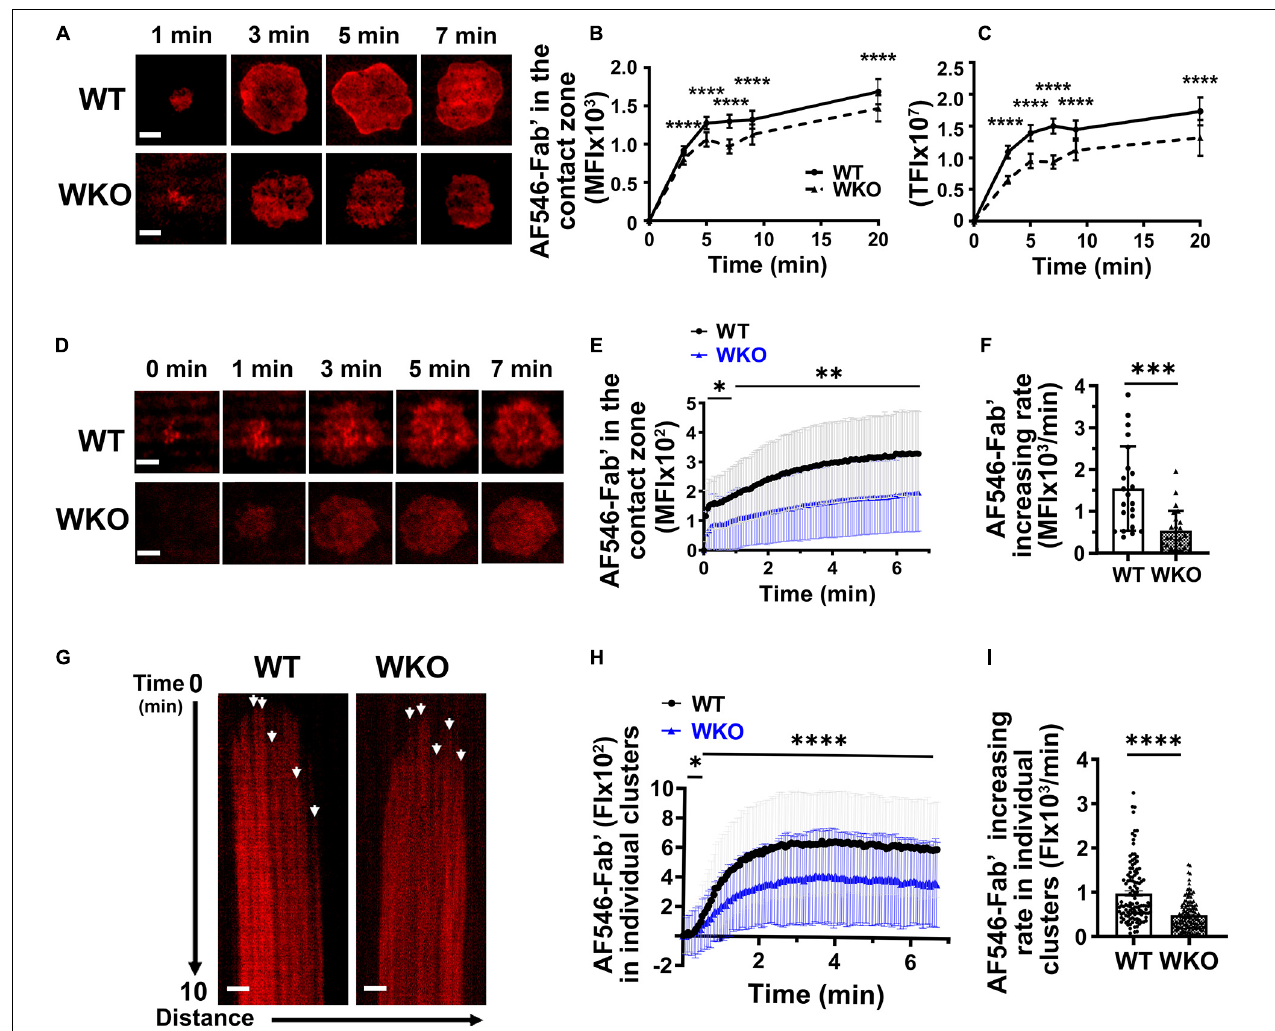
FIGURE 3 | WASp promotes BCR clustering in response to Fab’-PLB. GCBs isolated from SRBC-immunized WT and WKO mice were incubated with AF546-Fab’-PLB and were imaged either after fixation at varying times or live using TIRF. (A) Representative AF546-Fab’ images of GCBs fixed at 1, 3, 5, and 7 min. (B,C) The MFI (B) and TFI (C) of AF546-Fab’ in the contact zone of fixed GCBs over time using NIH ImageJ. (D) Representative time-lapse AF546-Fab’ images of WT and WKO GCBs. (E) MFI of AF546-Fab’ in the GCB contact zone over time. (F) Increasing rates of AF546-Fab’ MFI in the contact zone of individual GCBs were determined using slops of AF546-Fab’ vs. time plots and linear regression, as shown in Figure 2E . Data points represent individual cells. (G) Representative kymographs generated using AF546-Fab’ time-lapse images of the WT and WKO GCB contact zone using NIH ImageJ. White arrows, the starts of individual AF546-Fab’ clusters. (H) The FI of AF546-Fab’ in individual clusters over time using kymographs and NIH ImageJ. (I) Increasing rates of AF546-Fab’ FI in individual clusters were analyzed as described in Figure 2E . Data points represent individual clusters. Scale bars, 3 µ m. The results were the averages ( ± SD) of 22 ∼ 100 individual cells (B,C,E) , or > 120 BCR clusters and 5 clusters per kymograph per cell (H) for each condition. n = 4 ∼ 7. ** p < 0.01, *** p < 0.001, and **** p < 0.0001, unpaired Student’s t -test or one-way